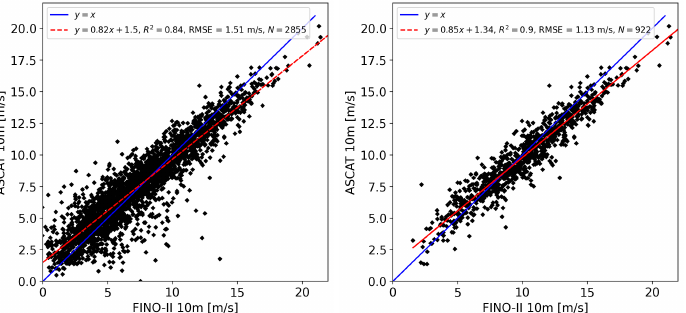
Figure 6. Scatter of extrapolated 10 m FINO2 wind speed measurements with ASCAT 10 m. ( left ) All co-located extrapolated values ( right ) filtered for near neutral stabilities ( − 0.2 ≤ ζ ≤ 0.2). The blue line is y = x and the red line is the resultant linear regression.